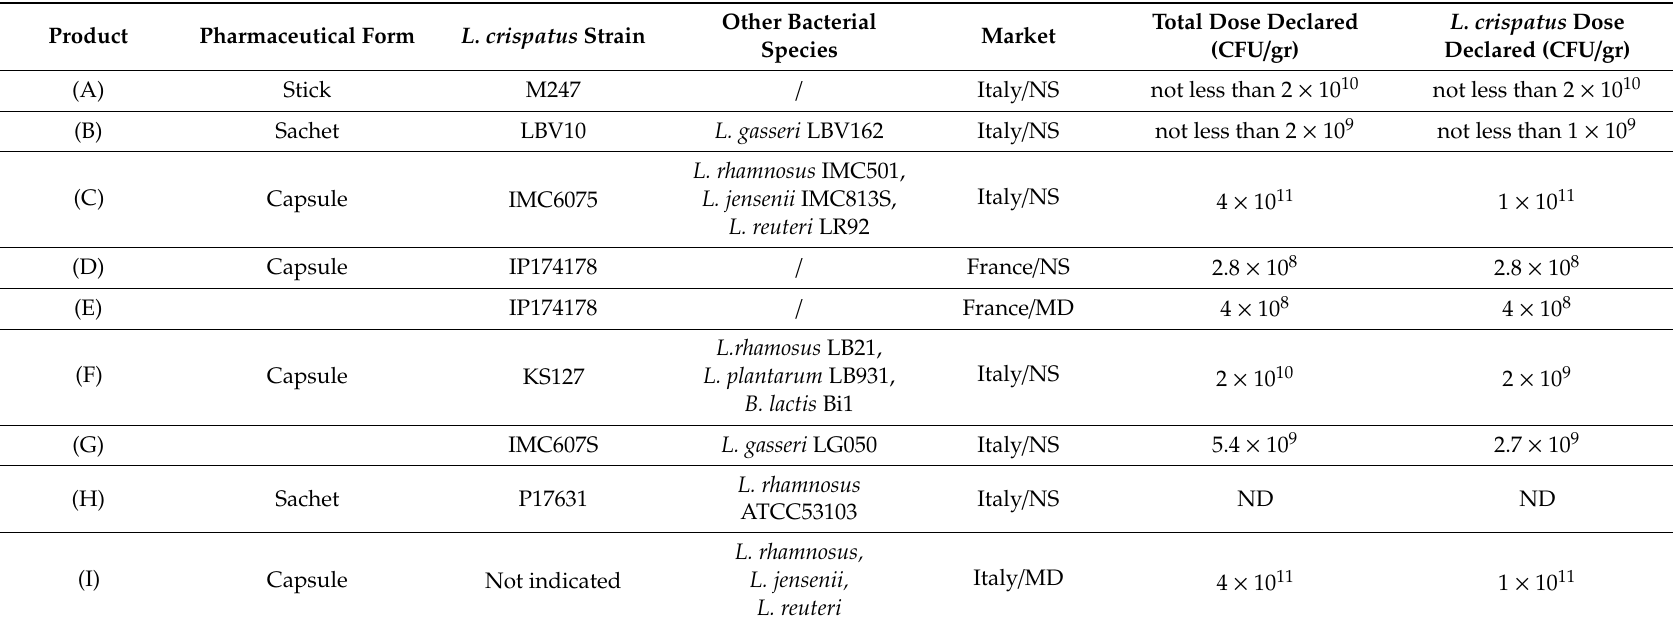
Table 1. Microbiological compositions and viable count values declared on